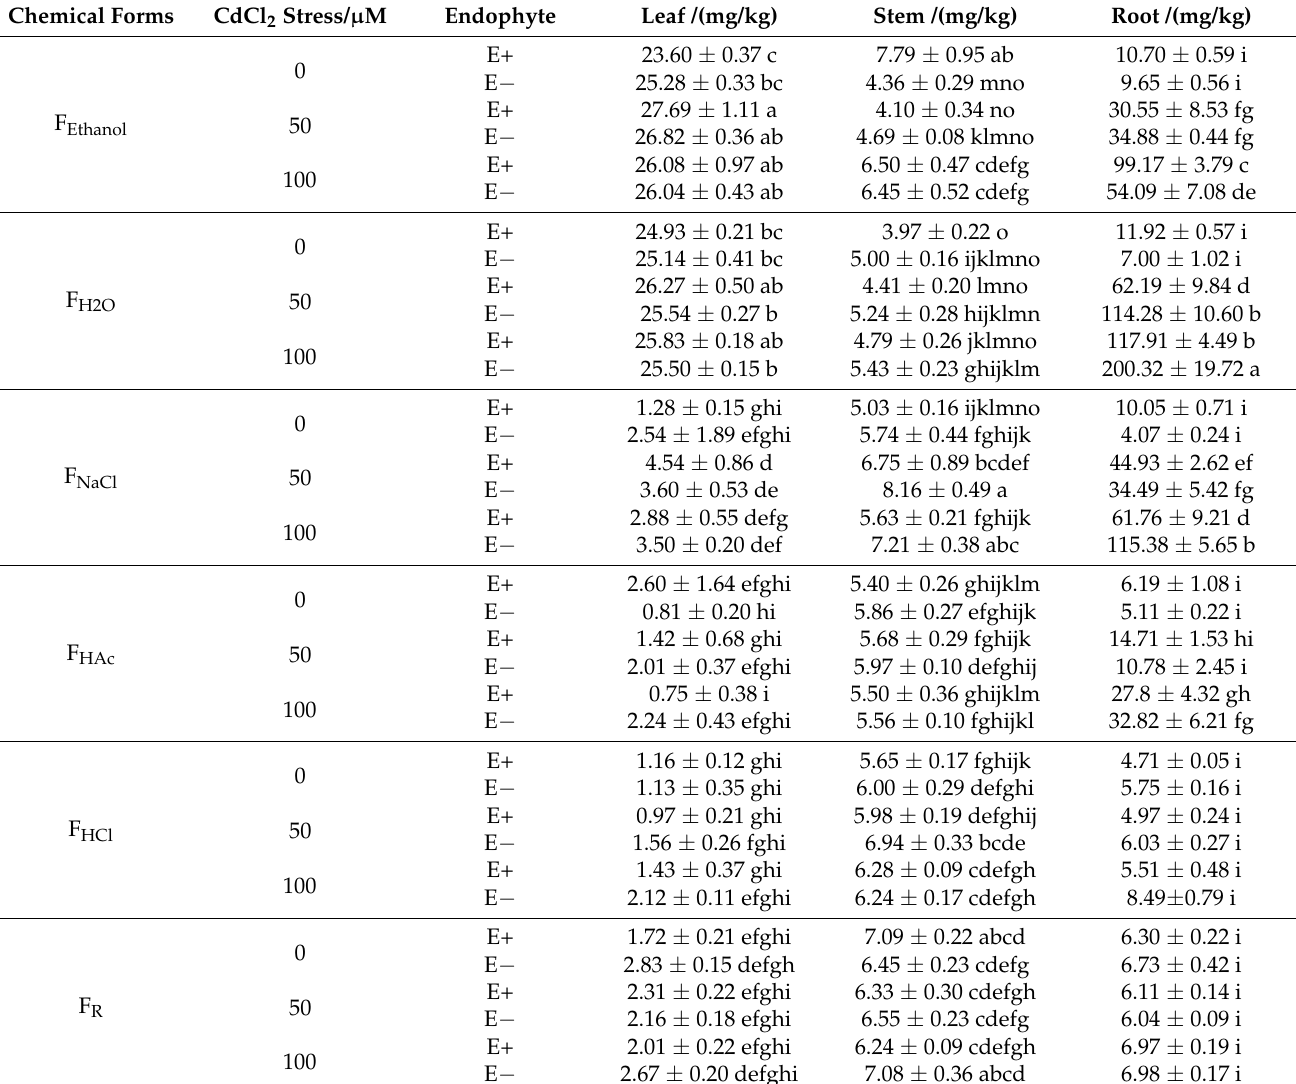
Table 6. Concentrations of chemical forms of Cd in leaves, stems and roots of H. brevisubulatum . Chemical